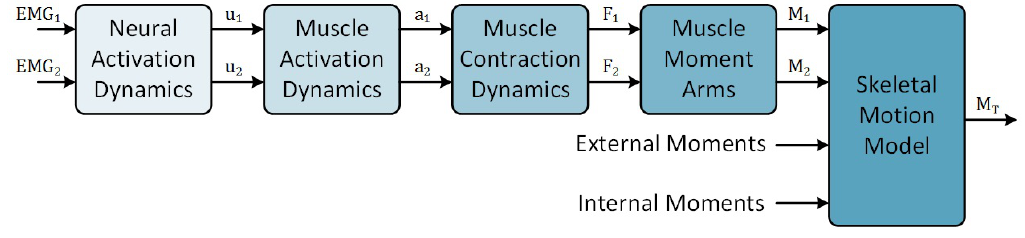
Figure 1. General muscle-level motion model framework illustrating the forward calculation of joint moment, M T , from two antagonistically configured muscles (indicated by subscripts 1 , 2 ). EMG is the raw EMG signal obtained from the muscle; u is neural activation generated from the EMG signal; a is the muscle activation signal; F is the force produced by each muscle; and M is the muscle torque generated about the joint of interest. This configuration represents a simplistic configuration of a muscle-level elbow motion estimation